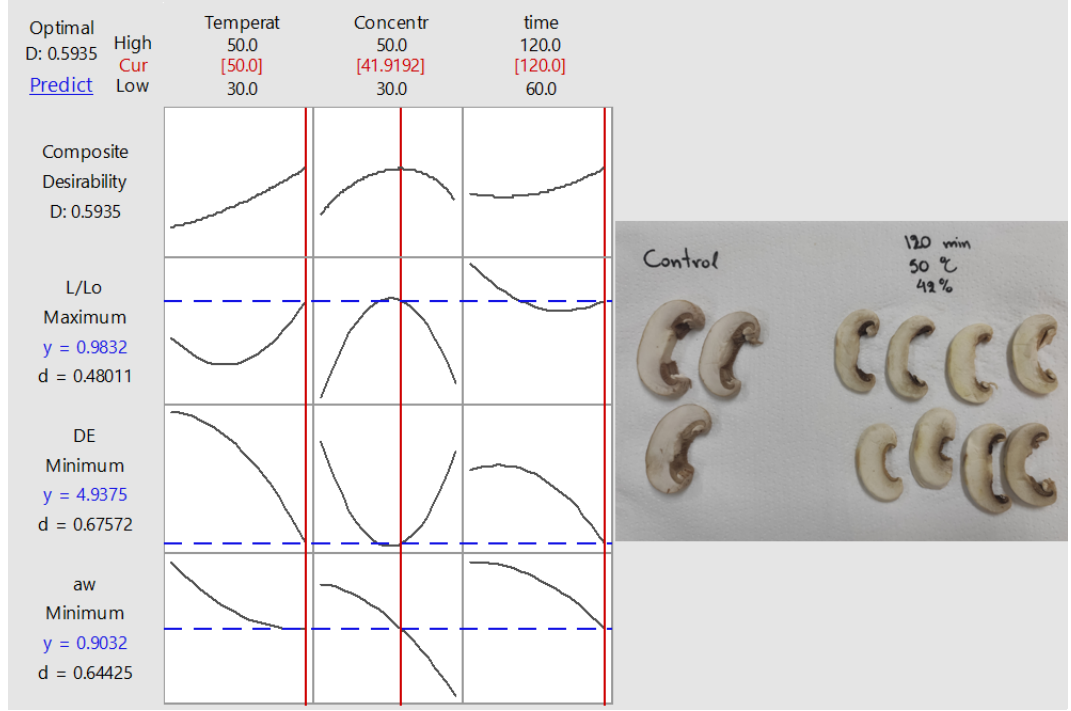
Figure 9. Desirability plot of variables and illustration of mushroom samples at the optimized conditions.